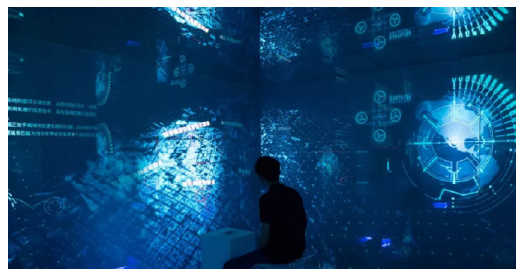
Figure 1. Immersive somatosensory